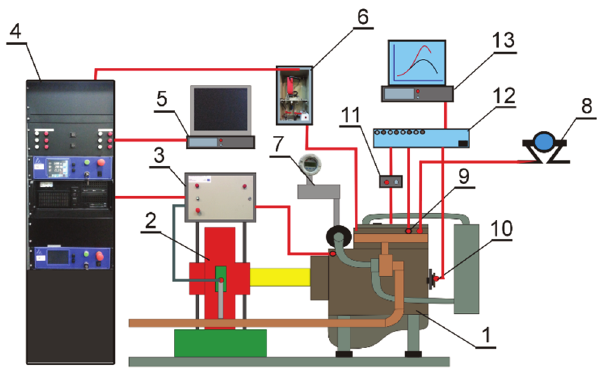
Fig. 2. Test stand elements: 1– Perkins 1104D - E44TA engine, 2 – Au- tomex AMX 200/6000 brake, 3 – measurement module, 4 – measurement cabinet with stand control system, 5 – computer to control station parame- ters and archive test results, 6 – Automex ATMX2040 mass fuel dosime- ter, 7 – ABB mass air flow meter, 8 – Coriolis flow meter for measurement of CNG consumption, 9 – sensor of the pressure in the engine cylinder, 10 – engine crank angle encoder AVL 365C, 11 – converter for measuring the current controlling the operation of the injector LA25NP, 12 – AVL IndiSmart 612 system for indicating fast-changing quantities, 13 – com- puter for archiving fast-changing quantities